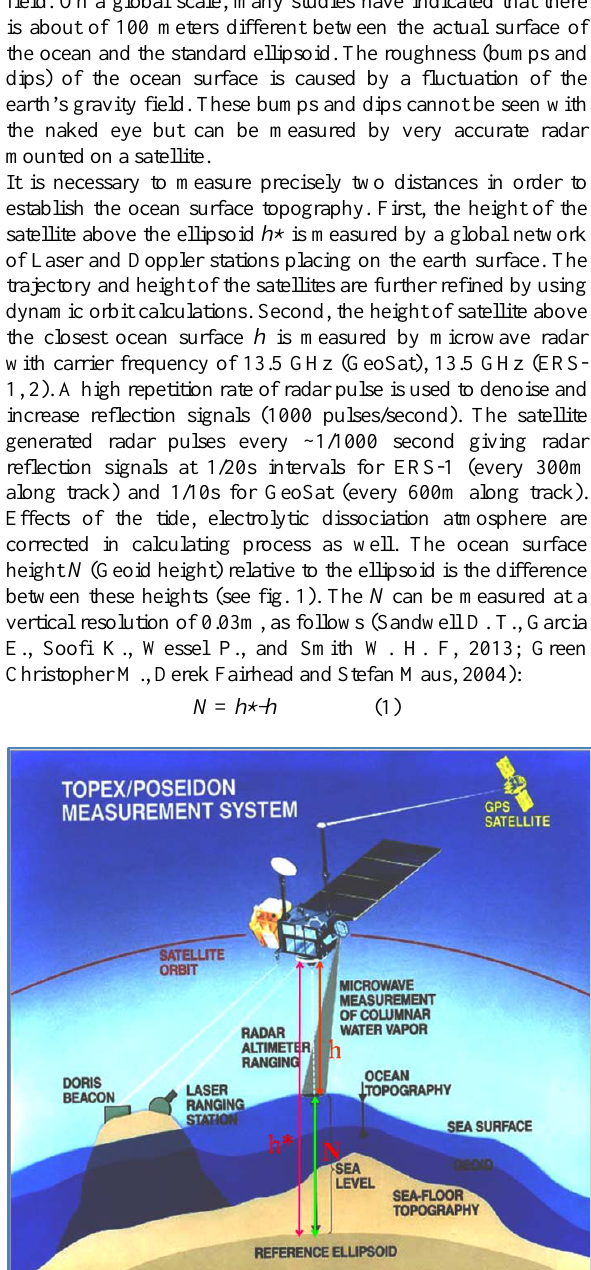
Figure 2. Comparison of shipboard data (dashed lines) and satellite altimetry-derived (solid lines); a> satellite-derived and shipboard gravity profiles; b> Satellite-derived and shipboard depth